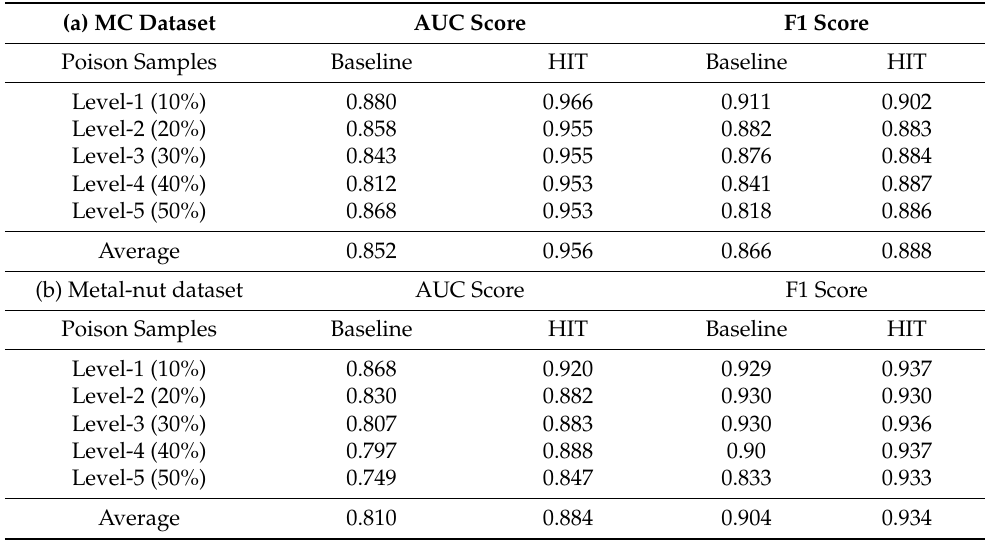
Table 3. Comparison of results between the baseline network with and without the addition of our proposed HIT module on five levels of poison